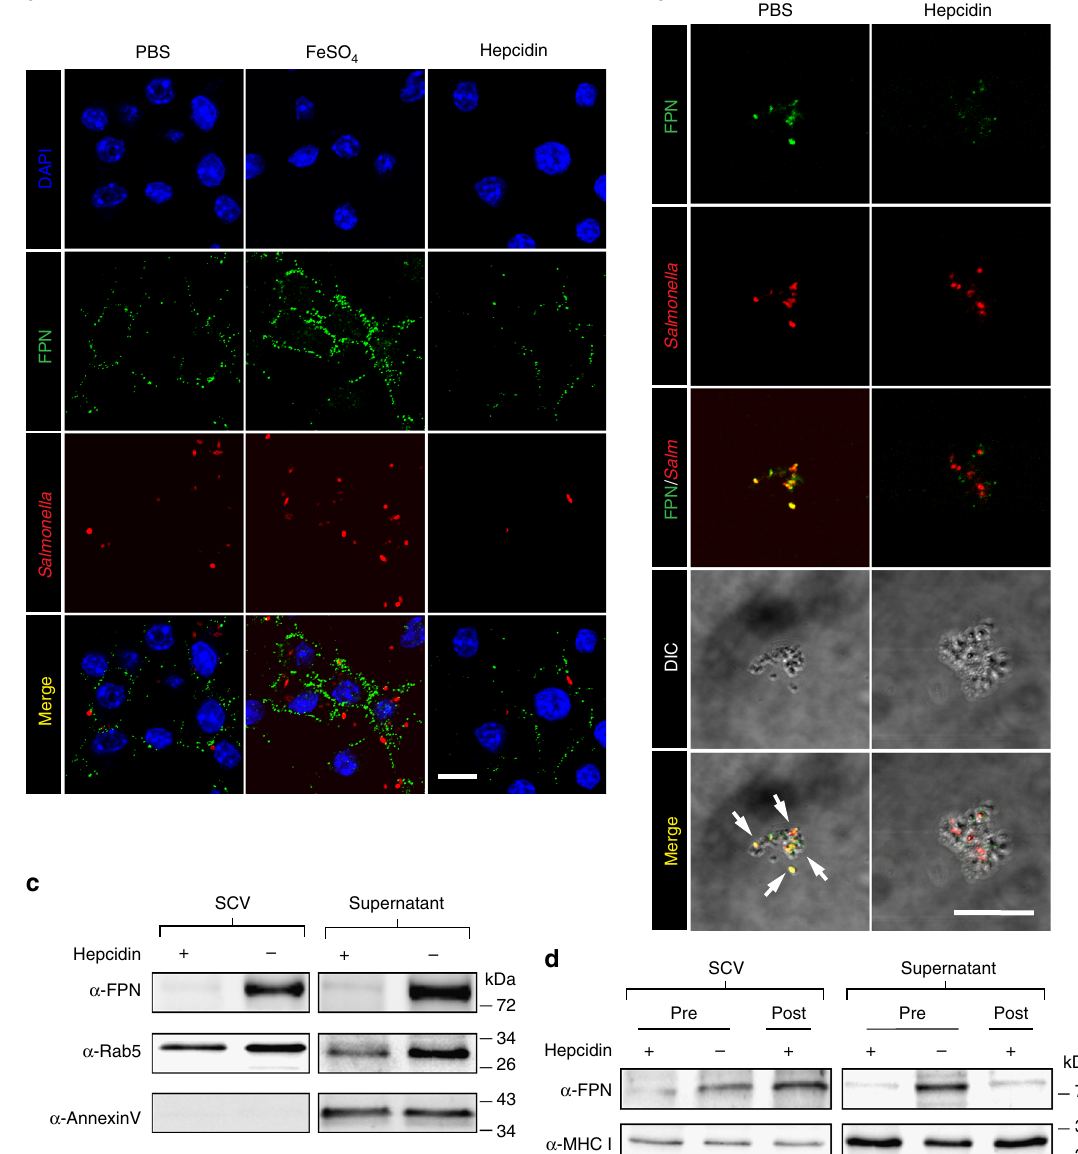
Fig. 1 The presence of FPN in the SCV of Raw264.7 cells. a Raw264.7 cells pretreated with FeSO 4 (0.1 mM) and/or hepcidin (1 μ g/ml) for 3 h were infected with Salmonella (MOI, 100) and examined by confocal microscopy. Enlarged images of merge panels are shown in Supplementary Fig. 17. b The cells pretreated with PBS or hepcidin were infected with magnetized Salmonella (MOI, 100) for 2 h, and then SCV were isolated and Salmonella were analyzed by confocal microscopy. Staining for FPN is shown in green, and Salmonella in red. The isolated SCV were visualized by differential interphase contrast (DIC) imaging (scale bar 10 μ m). Images are representatives of over 500 isolated SCVs per group from at least three independent experiments. c Raw264.7 cells pretreated with hepcidin were infected with magnetized Salmonella . FPN, Rab5, and annexin V in the SCV and the non-SCV fraction (supernatant) were examined by western blotting using speci fi c antibodies. d Alternatively, Raw264.7 cells infected with Salmonella were treated with hepcidin for 2 h post infection and analyzed as in